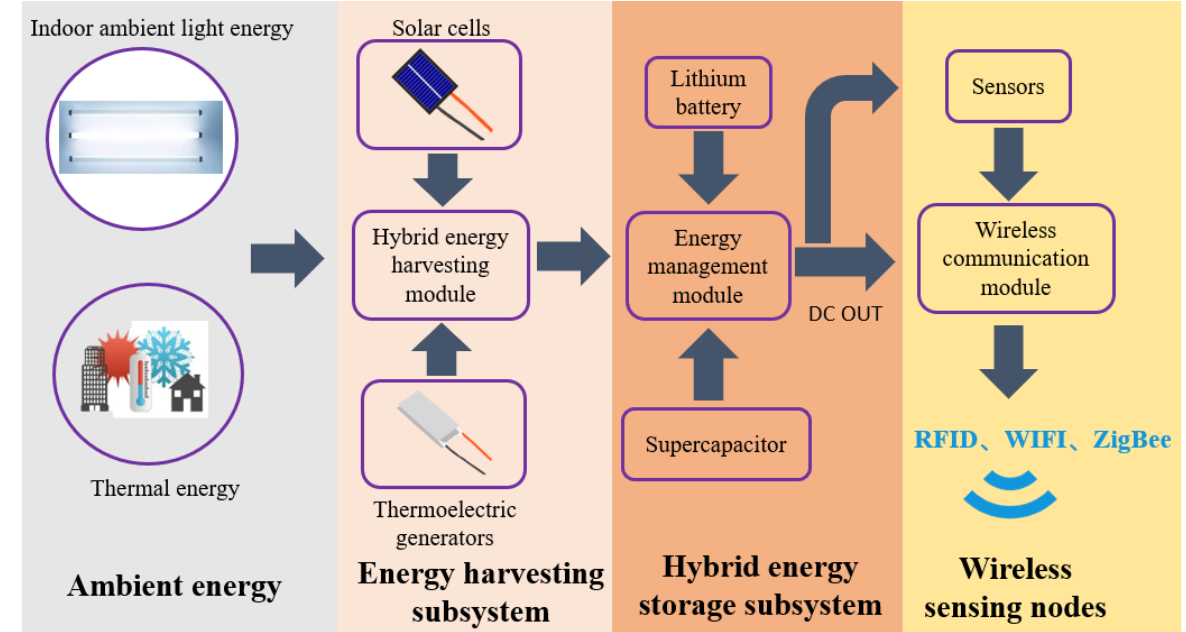
Figure 1. System framework of the proposed self-powered IoT sensor node.